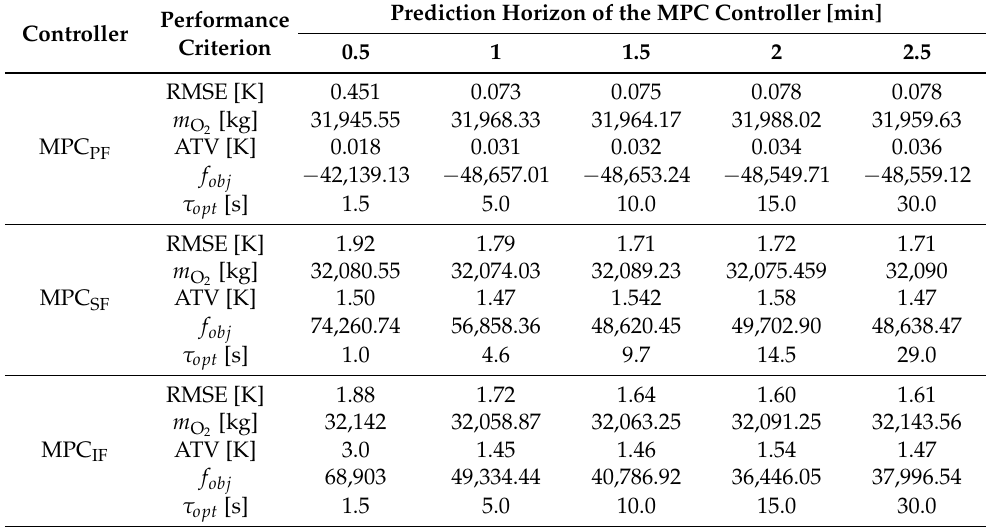
Table 4. MPC evaluation, for the three types of DNI forecasts (7-day simulation). RMSE is the root mean squared error. m O is the amount of oxygen injected in the reactor. ATV is the average 2 temperature variation. f obj is the objective function value. τ opt is the mean optimization time per time step. Reference performance (PID/RB controller): RMSE = 4.88 K, m O = 31,933 kg and ATV = 2.27 2